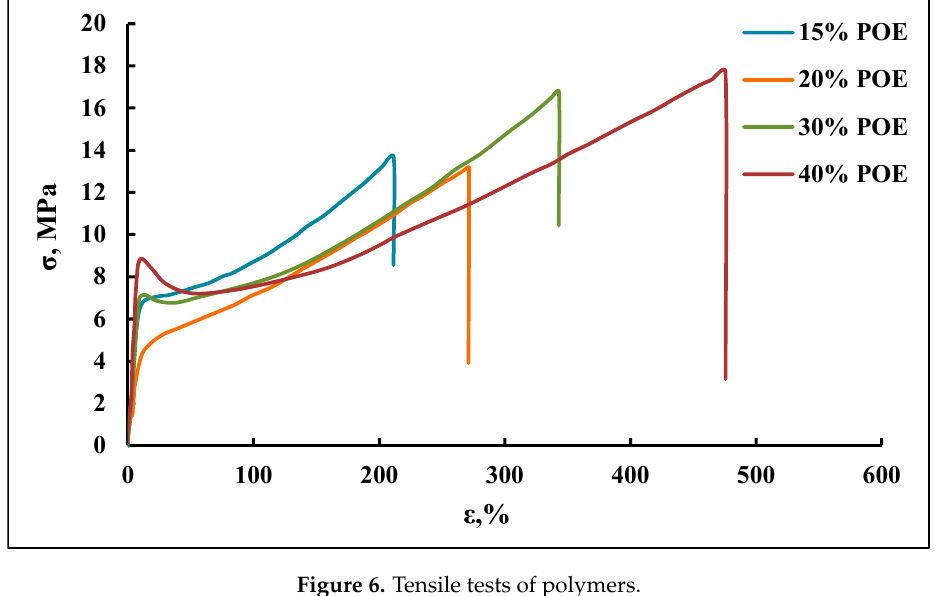
8 of 15 Figure 5. The curves of thermomechanical analysis of polymers. 3.1.2. Mechanical Behavior A change in the content of POE blocks leads to noticeable changes in the mechanical behavior of polymers (Figure 6). In this case, there is a change in the run of the curves and a regular increase in the relative elongation at the break of the samples with an increase in the percentage of POE blocks, which reflects the differences in their supramolecular organization. Such changes in the mechanical properties of block copolymers are the consequence of differences in their macromolecular structure. If the POE block content is 15 wt %, the polyoxypropylene segments are